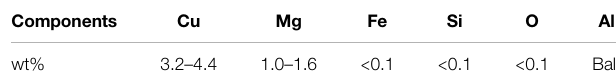
TABLE 1 | Chemical composition of 2009 Al alloy powder.